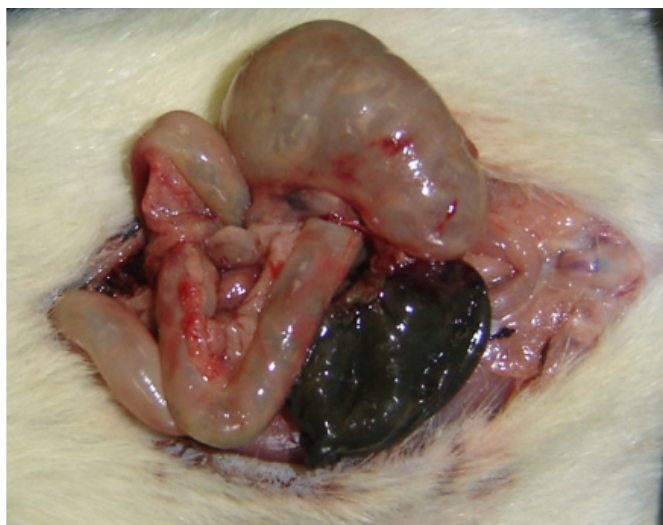
FIGURE 4 - Diffuse peritonitis following cecum ligation and distal needle puncture